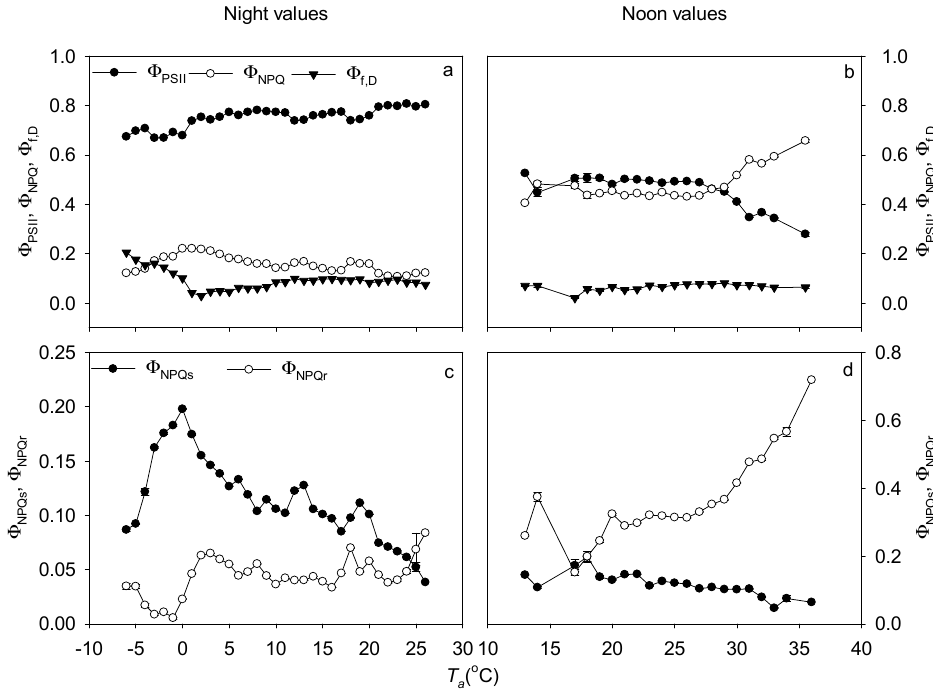
Figure 6. Actual quantum yield of PSII photochemistry ( Φ PSII ), regulated thermal energy loss ( Φ NPQ ), non-regulated energy loss ( Φ f,D ), sustained and rapidly reversible thermal dissipation ( Φ NPQs and Φ NPQr ) as a function of air temperature ( T a ) at night ( PAR < 5 μ moL·m − 2 ·s − 1 ; ( a , c )) and at noon ( PAR ≥ 1000 μ moL·m − 2 ·s − 1 ; ( b , d )), respectively, during the 2012 growing season. Data points of energy partitioning represent bin-averaged values. Here, the bins are set at 1 °C increments of T a with a minimal sample size of six values. The error bars denote standard error.